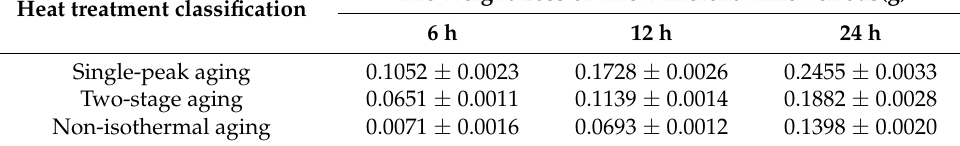
Table 9. The corrosion weight loss of the 7N01 extrusion aluminum alloy with different aging after different time